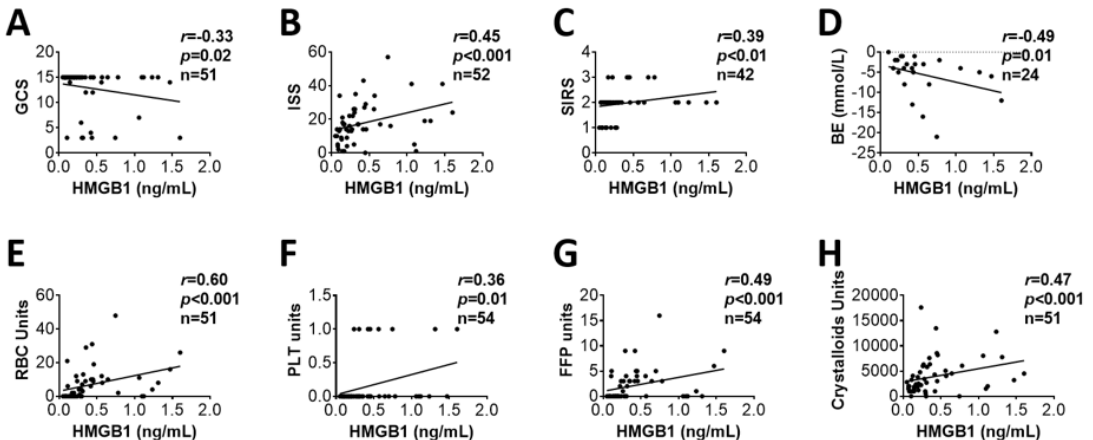
Figure 3. HMGB1 blood plasma concentrations correlated with clinical outcomes in trauma patients on admission. Positive correlations of HMGB1 blood plasma levels with ISS ( B ), SIRS ( C ), units of RBCs ( E ), units of platelets ( F ), units of fresh frozen plasma ( G ), and infused fluid ( H ) are shown. Negative correlations of HMGB1 plasma levels with GCS ( A ), and BE/BD ( D ) were observed. Correlation analyses were performed by using Spearman’s rank correlation, and the data are presented with coefficient (r s ) and p -values. Significant correlations ( p < 0.05) are indicated by boldface